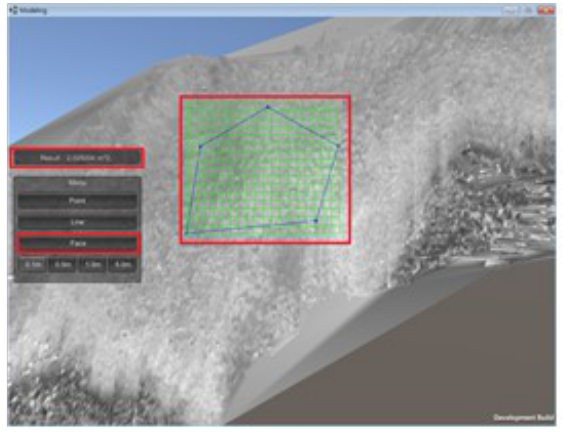
Figure 8. Calculation of Selected